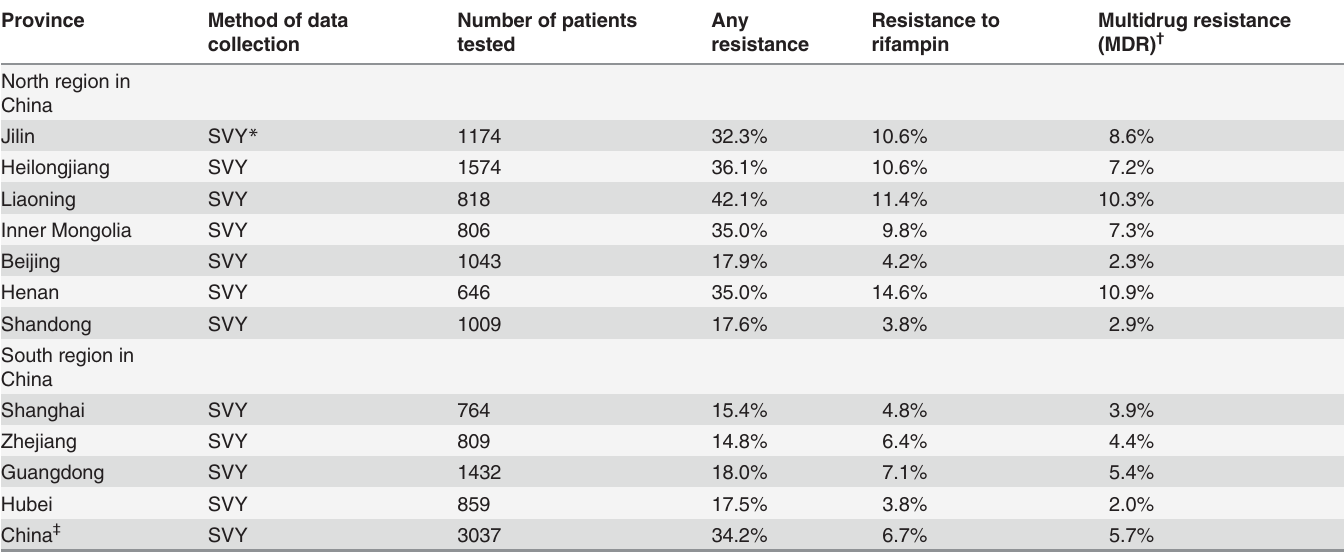
Table 4. Proportion of drug resistance in new tuberculosis cases tested in 11 Chinese